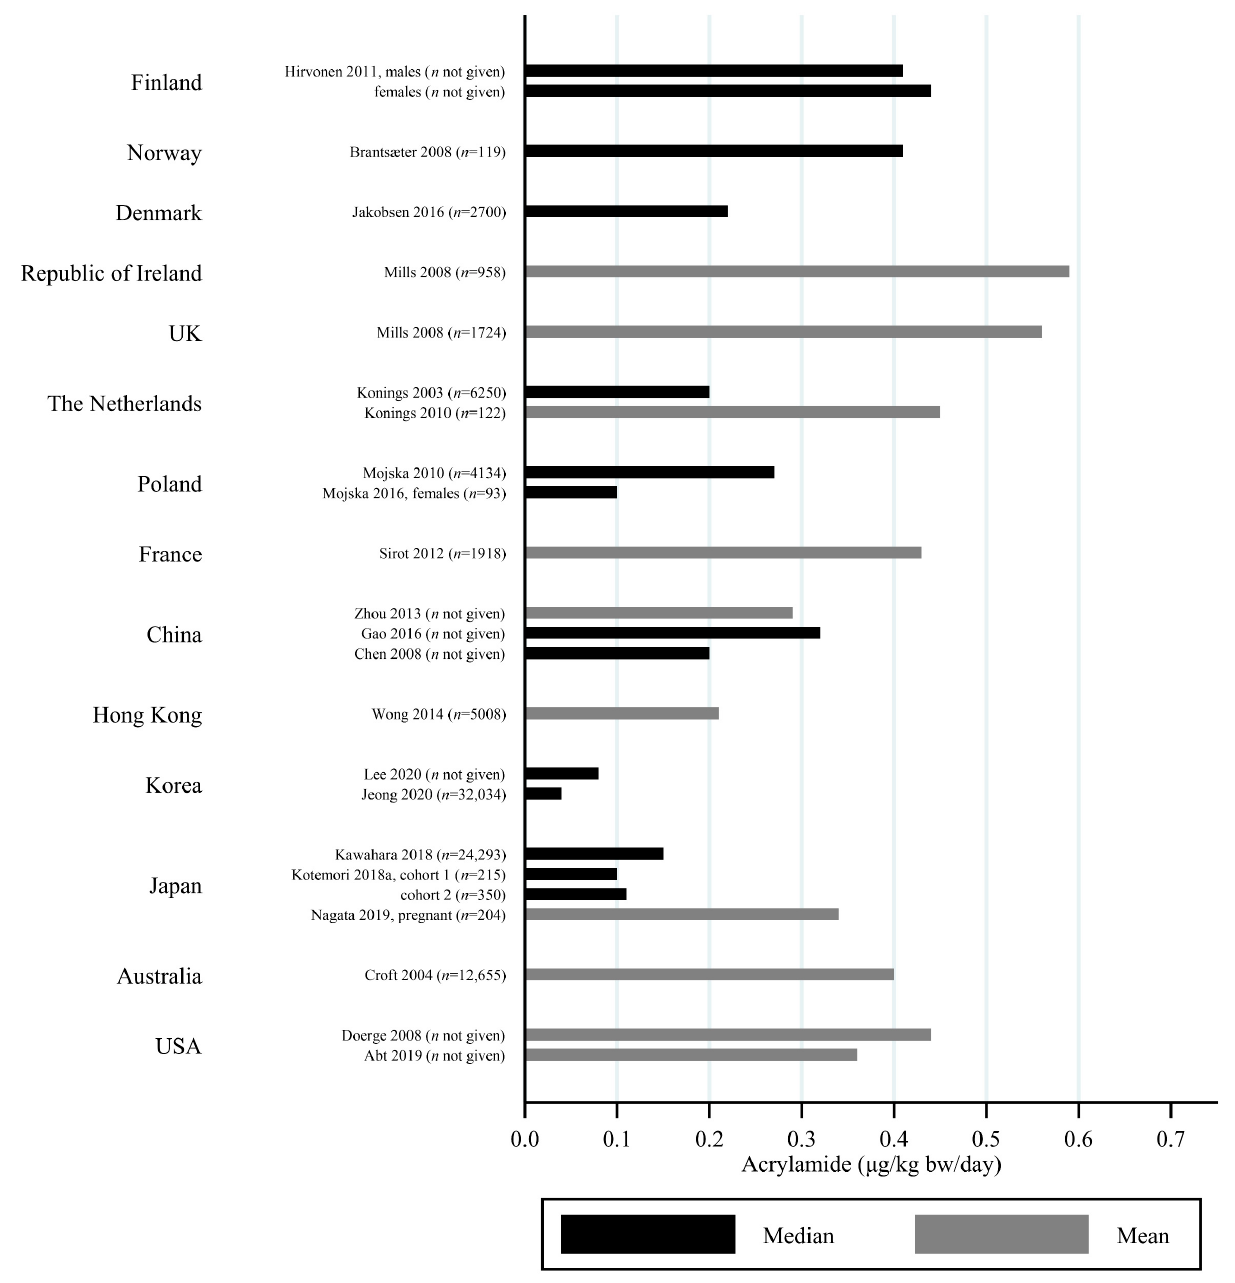
Figure 5. Median/mean estimated daily acrylamide intake per kg body weight ( μ g/kg bw/day), based on dietary recall, by country.